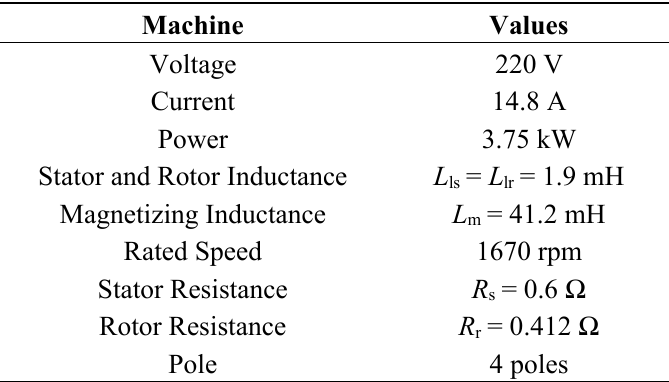
Table 2. Prototype induction motor